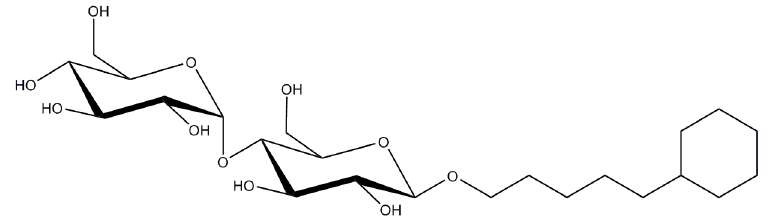
Figure 13. Structure of Cymal-5 (chemical formula is C 23 H 42 O 11 ; Cymal-6 has an extra carbon atom in its tail with formula C 24 H 44 O 11 ).